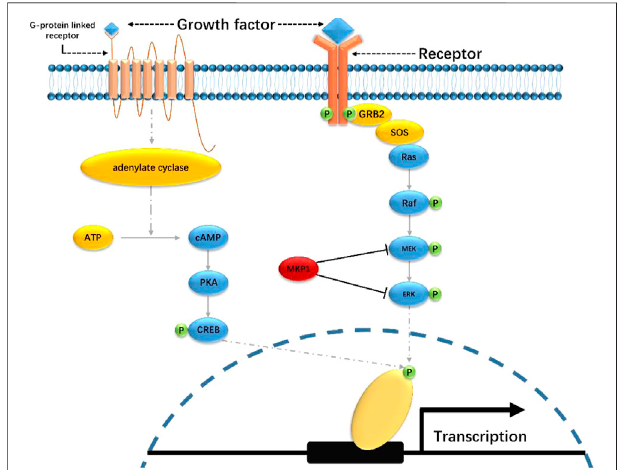
FIGURE 2 | MAPK and cAMP signaling